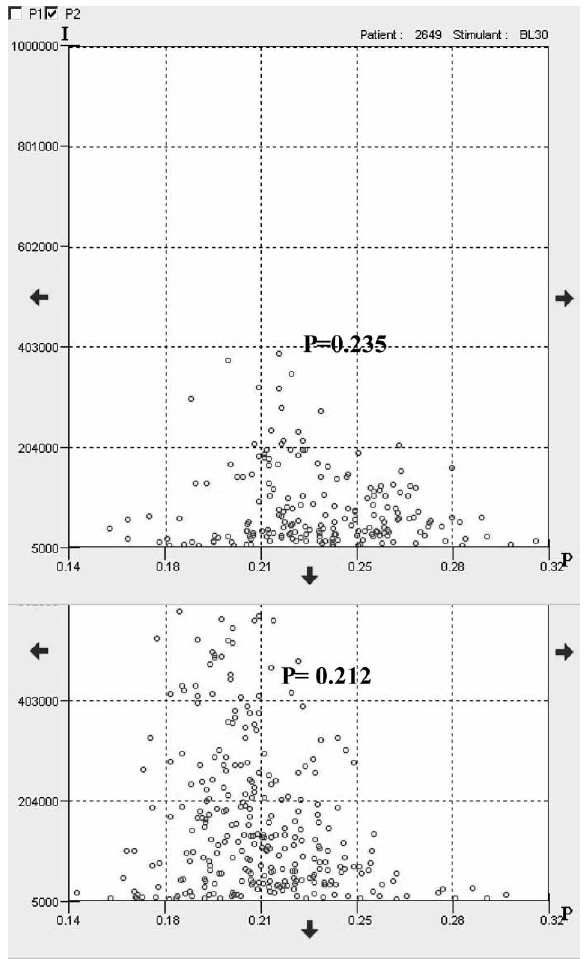
Figure 2. Scatter plots of FI (vertical axis) vs. FP (horizontal axis) of control (A) and PHA-treated lymphocytes (B). The drop in average FP (marked P in the center of the figure) of PHA-treated lymphocytes is